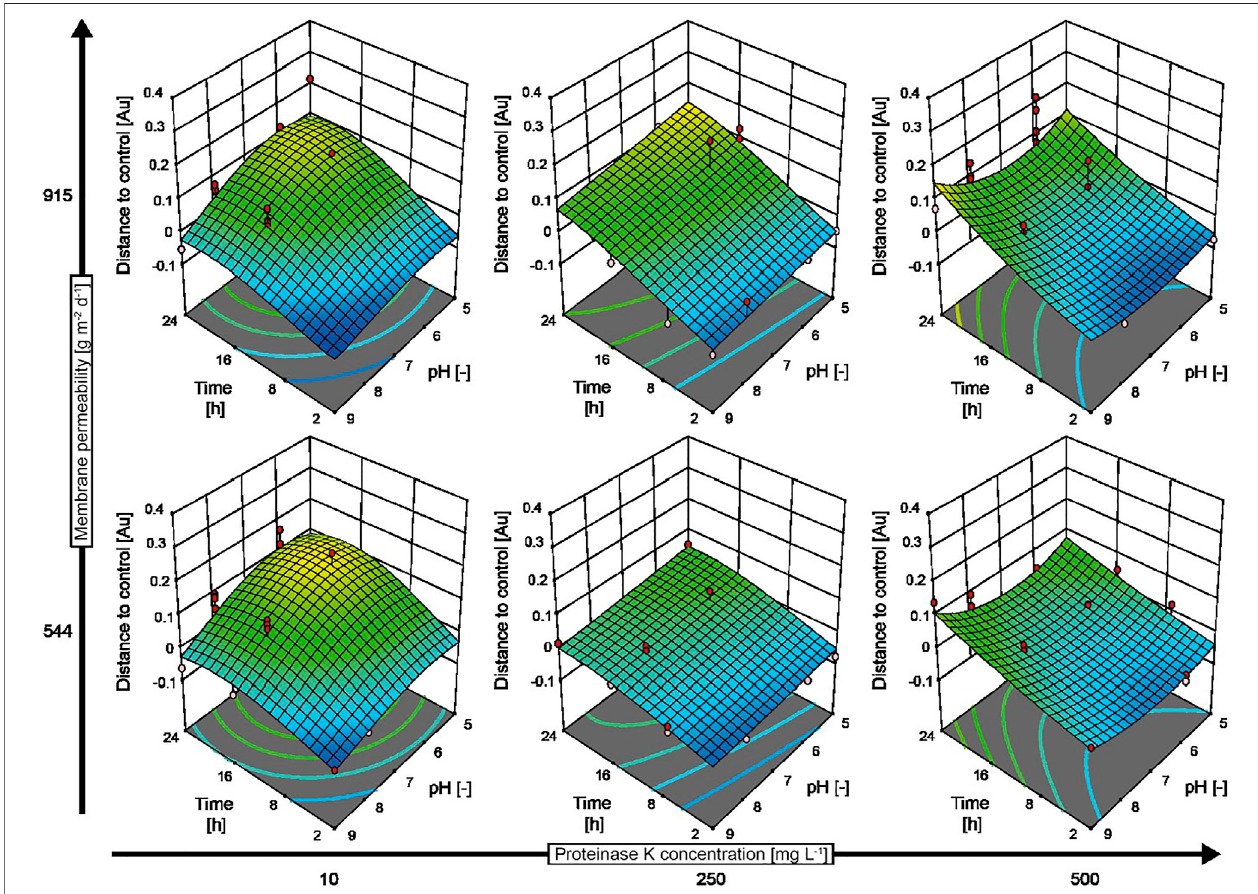
FIGURE 4 | Response surface model predicting the behavior of B. subtilis WB800N bio fi lms in response to treatment with proteinase K. An I-optimal split-plot design with 128 runs was obtained in two blocks. The data were calculated by subtracting the signal measured for control bio fi lms (incubated in assay buffer without enzyme)fromthesignalmeasuredforenzymaticallytreatedbio fi lms.Negativevaluesindicateareductioninbio fi lmthickness,whereaspositivevaluesdenoteanincrease in bio fi lmformationcompared tothecontrol.Experimentaldata aredisplayed asred (above themodel prediction)and pink (below themodel prediction) dotsin the graphs. The assay buffer was 50 mM MES (pH 5.0) or 50 mM TRIS (pH 7.0 – 9.0) and 5 mM calcium chloride.